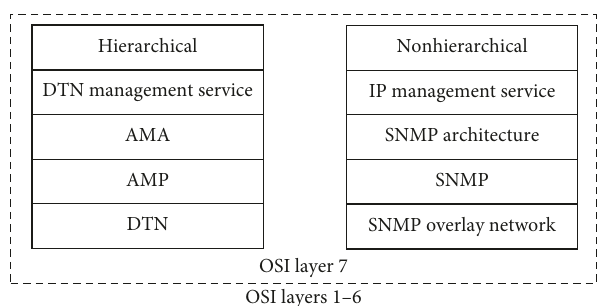
5: The network management responsibility stack of a hi- erarchically structured DTN (left) and a nonhierarchical SNMP management network